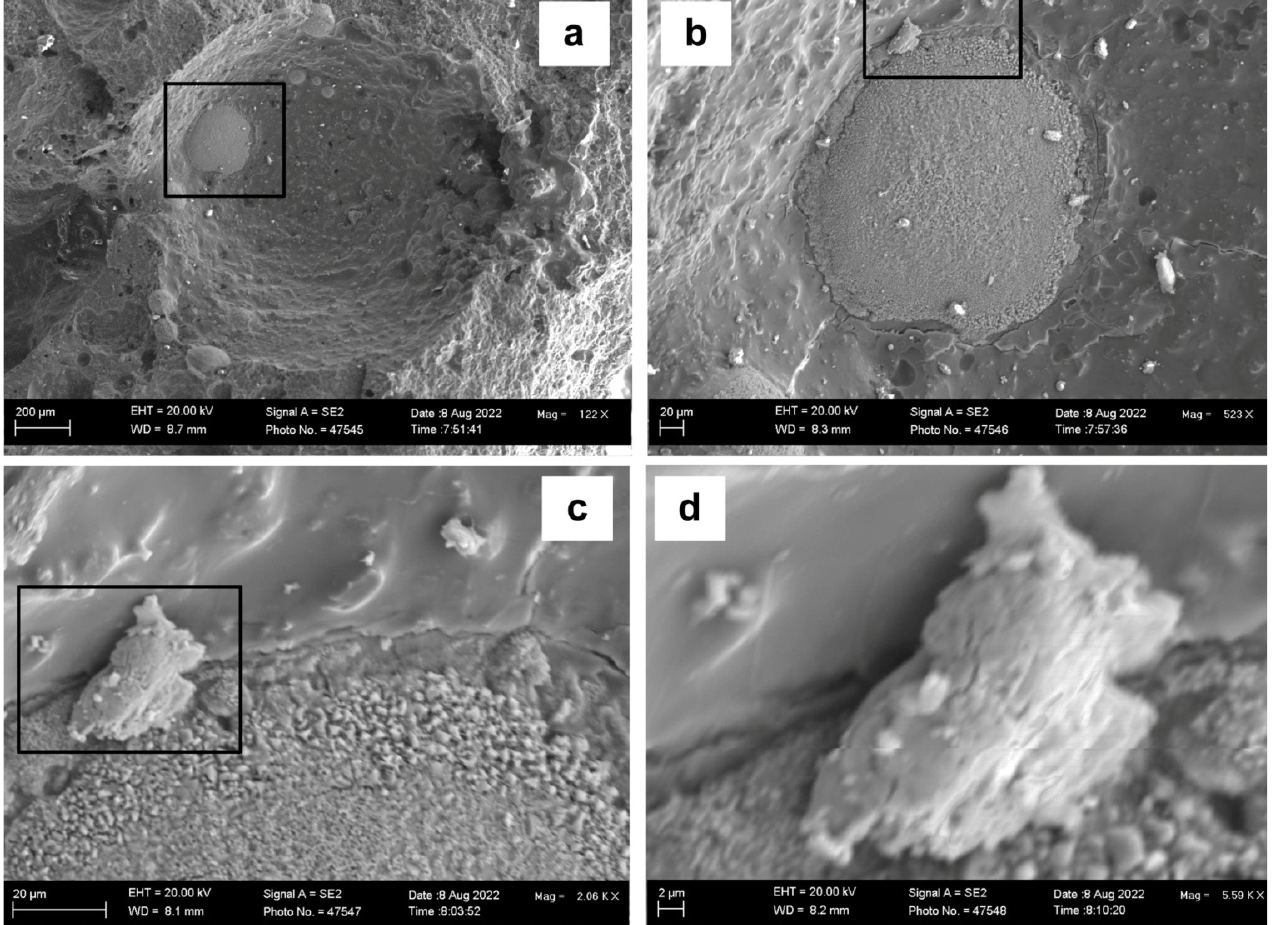
Figure 2. BSE image of dome in MP2 slag sample: ( a ) at 122× magnification; ( b ) at 523× magnification; ( c ) at 2060× magnification; ( d ) at 5590× magnification.